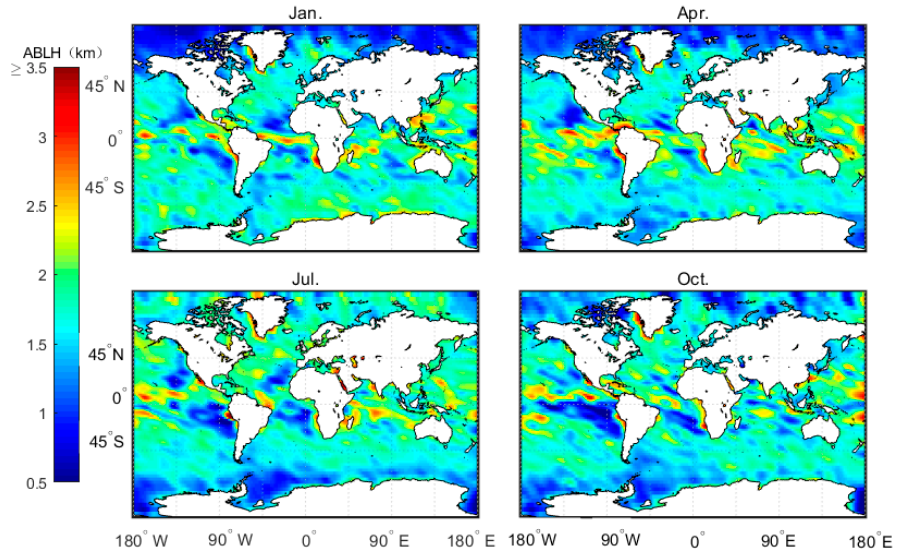
Figure 6. Average MBLH over four months based on the 2007–2011 CDAAC atmprf bending angle products.